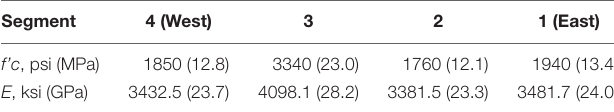
TABLE 5 | Parameters of concrete for each of the slab’s segments.